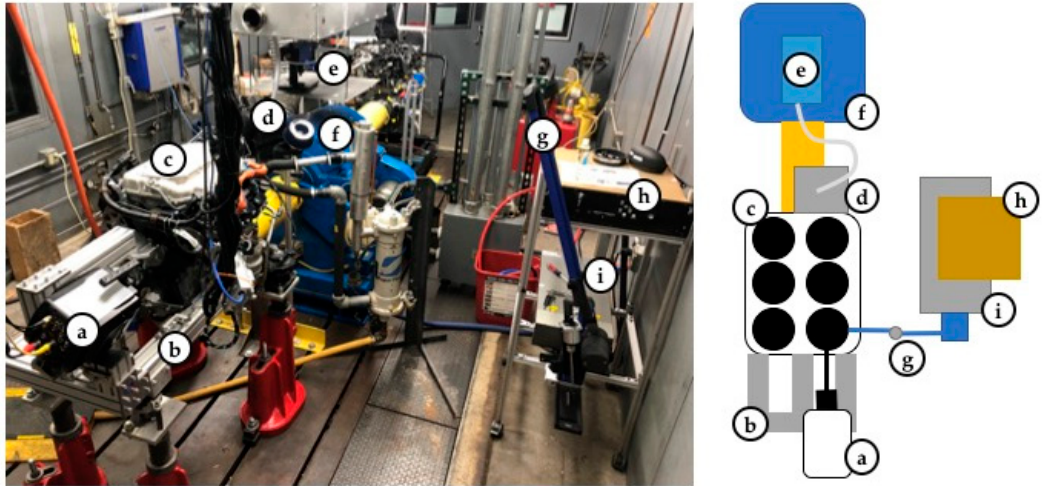
Figure 1. Picture ( left ) and schematic ( right ) of the engine test cell and experimental setup: (a) high speed camera; (b) camera support frame; (c) engine; (d) air box; (e) particle seeder; (f) AC dyno; (g) articulated guide arm; (h) laser controller; (i) laser.